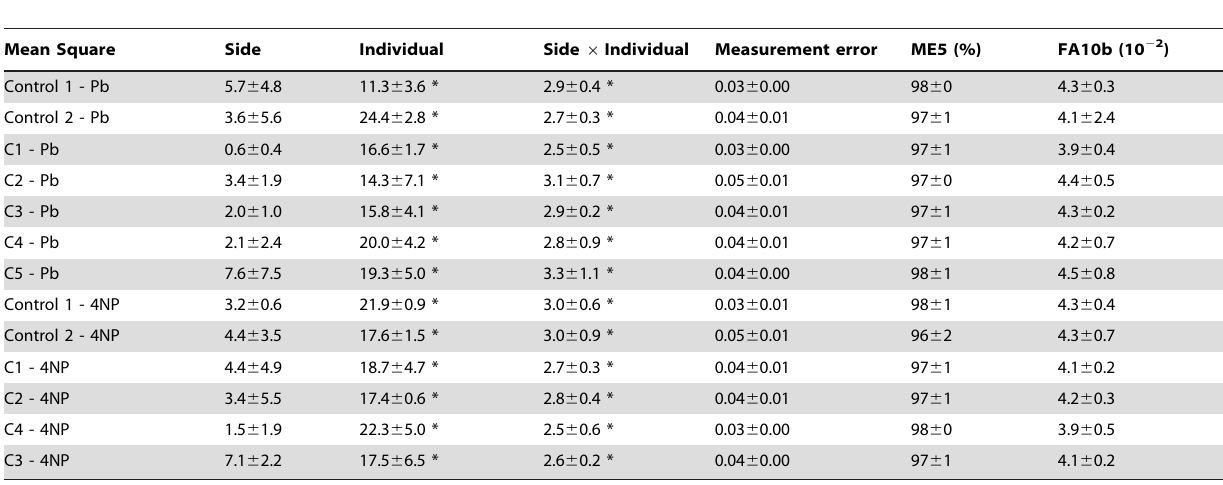
Table 3. Results of the two ways ANOVA (side 6 individual) for mentum length, measurement error descriptor (ME5) and FA level. Mean square average and standard deviation (10 2 3 ) between replicate.